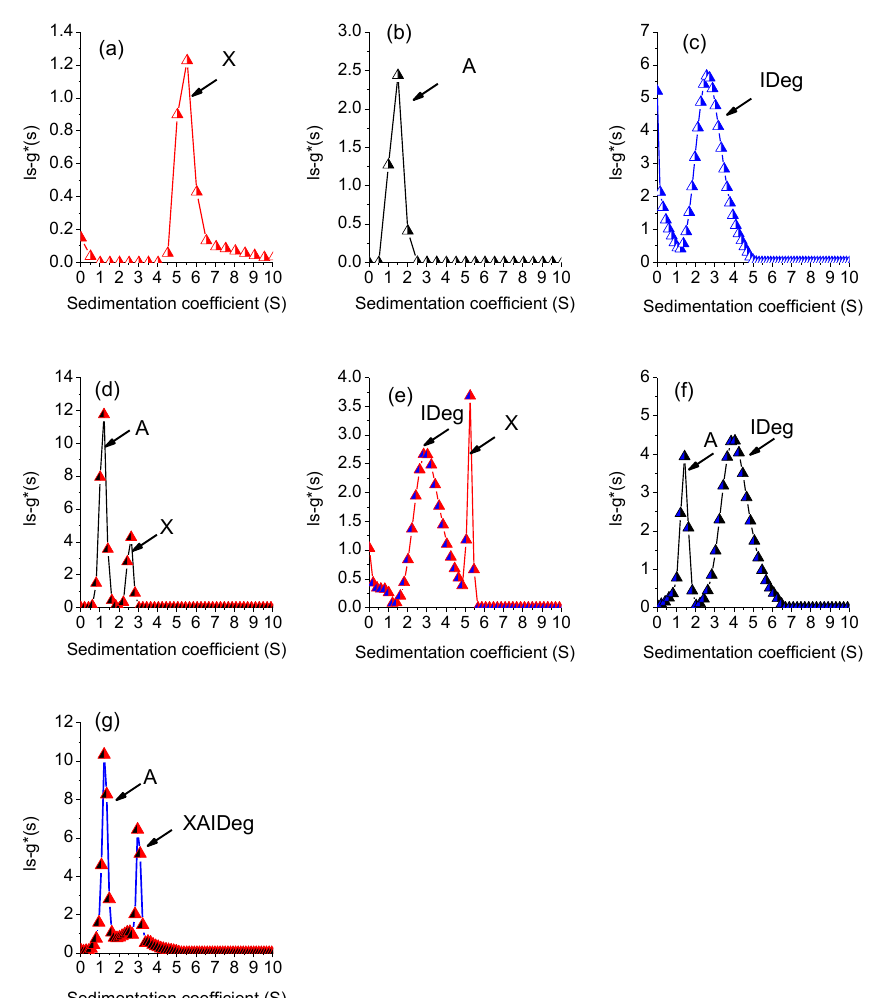
Figure 4. Plots of sedimentation coe ffi cient profiles for single, double and triple-component system where ( a ) xanthan, ( b ) alginate ( c ) Insulin Degludec, ( d ) X + A, ( e ) X + IDeg, ( f ) A + IDeg, ( g ) PIC = X + A + IDeg.